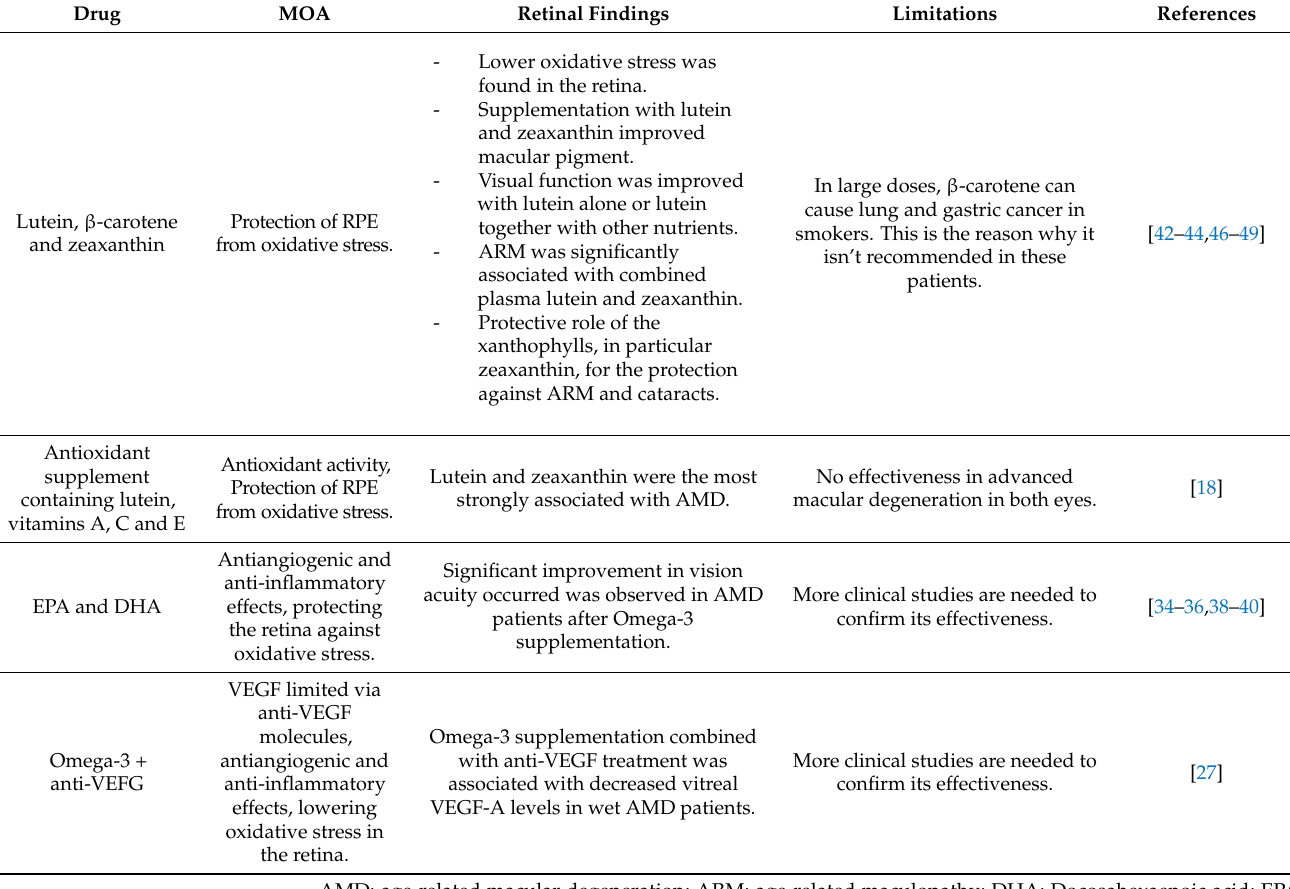
Table 2. Natural drugs proposed for AMD prevention in clinical trial studies on early AMD patients.